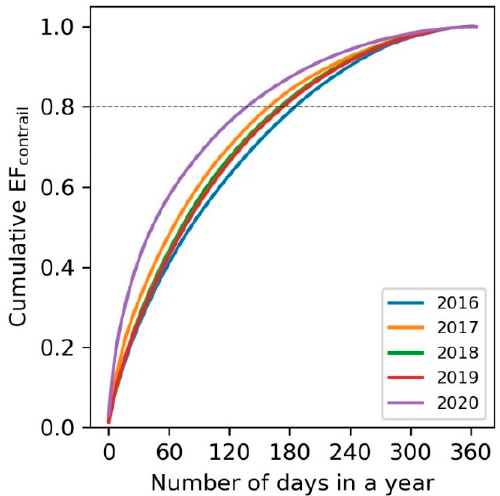
Figure 3. Cumulative density function of the annual EF contrail versus the number of days in a year that accounts for the proportion of EF contrail over the North Atlantic (Shanwick and Gander FIRs) between 2016 and 2020 (Derived using data provided by Teoh et al. [21]).